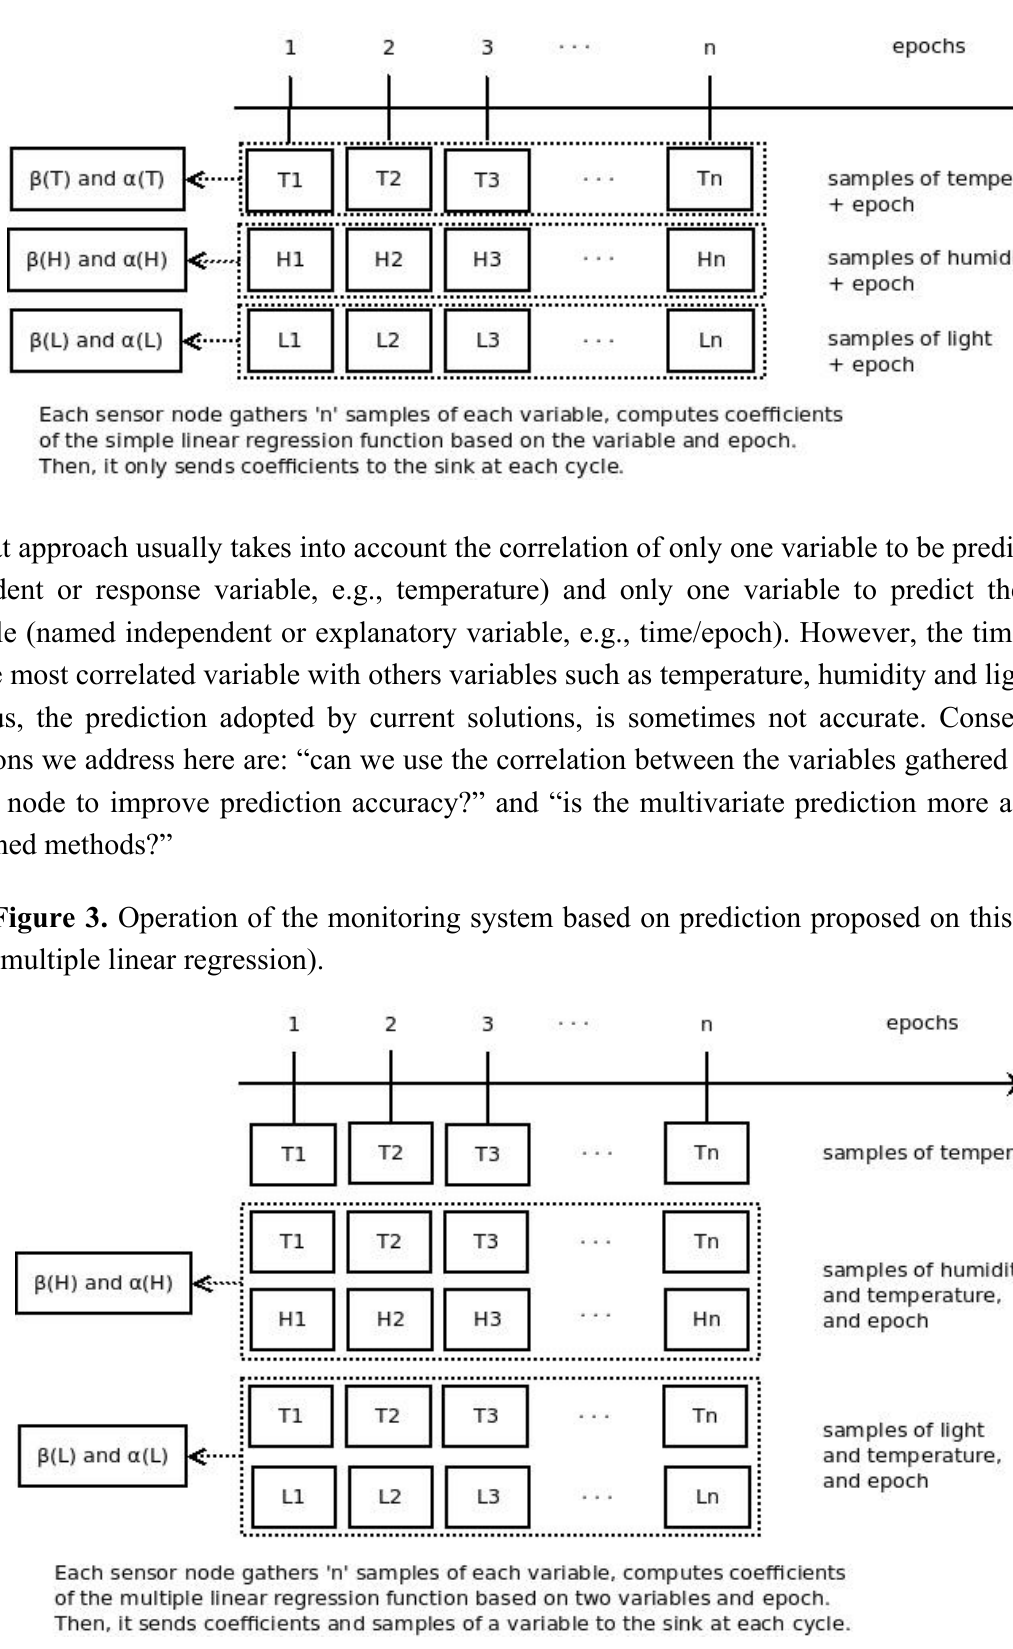
Figure 2. Operation of the monitoring system based on prediction proposed by current authors (simple linear regression).